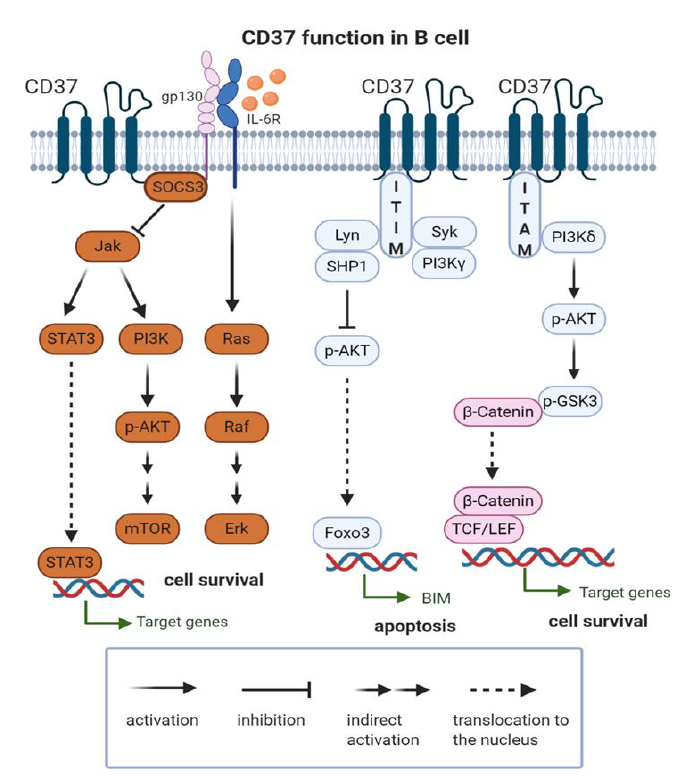
Figure 1. CD37 function in B cell. CD37 molecule is involved in activatory (PI3Kδ/p-Akt/p-GSK3/β-catenin ) and inhibitory (SHP1/p-Akt/Foxo3; SOCS3/Jak) signaling pathways. ITAM: immune tyrosine-based activation motif; ITIM: immune tyrosine-based inhibitory motif; IL-6R: Interleukin 6 Receptor; SOCS3: suppressor of cytokine signaling 3; Jak: Janus Kinase; STAT3: Signal Transducer and Activator of Transcription 3; PI3K: phosphatidylinositol 3-kinase; p-Akt: phospho-Akt; mTOR- mammalian target of rapamycin; SHP-1: Src homology region 2 domain-containing phosphatase-1; FOXO3: Forkhead box O3; p-GSK3: phospho-glycogen synthase kinase 3; TCF / LEF: T cell factor / lymphoid enhancer